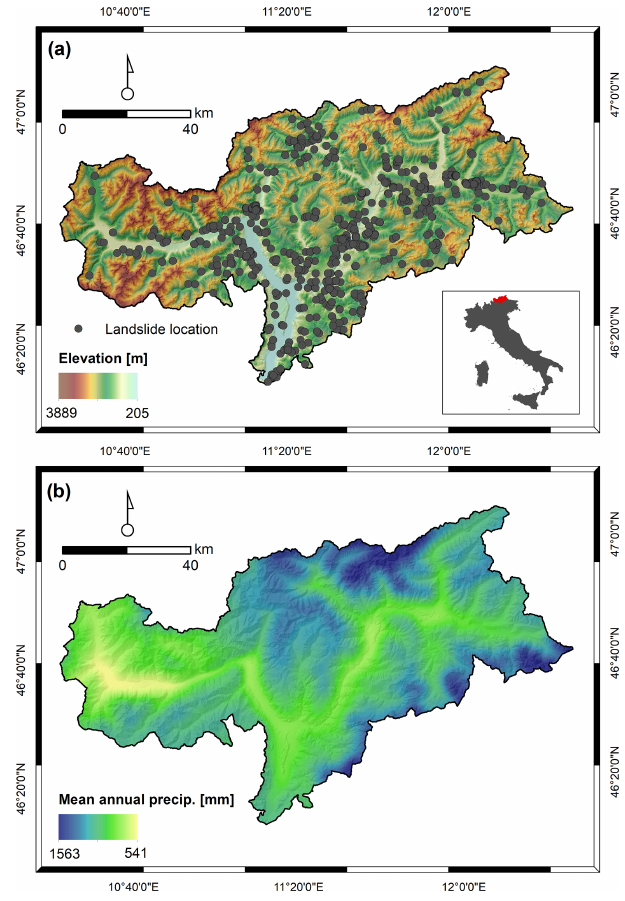
Figure 1. Position of the study area within Italy (insert within panel a ), elevation, and landslide scarp locations of the earth and debris slides ( n = 581) used for modelling (a) , and mean annual precipitation rates for the period 2000 to 2020 (b)